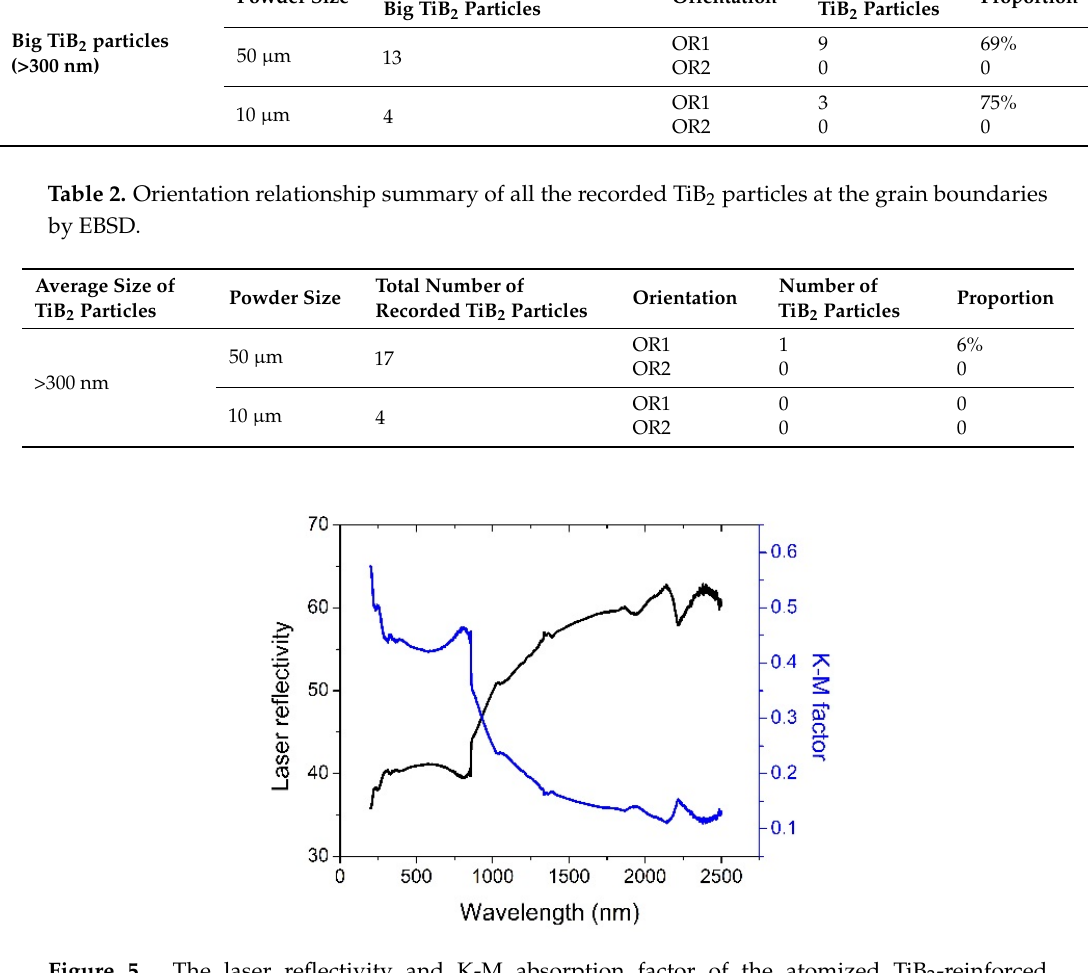
Table 1. Orientation relationship summary of all the recorded TiB 2 particles inside the grain by EBSD.